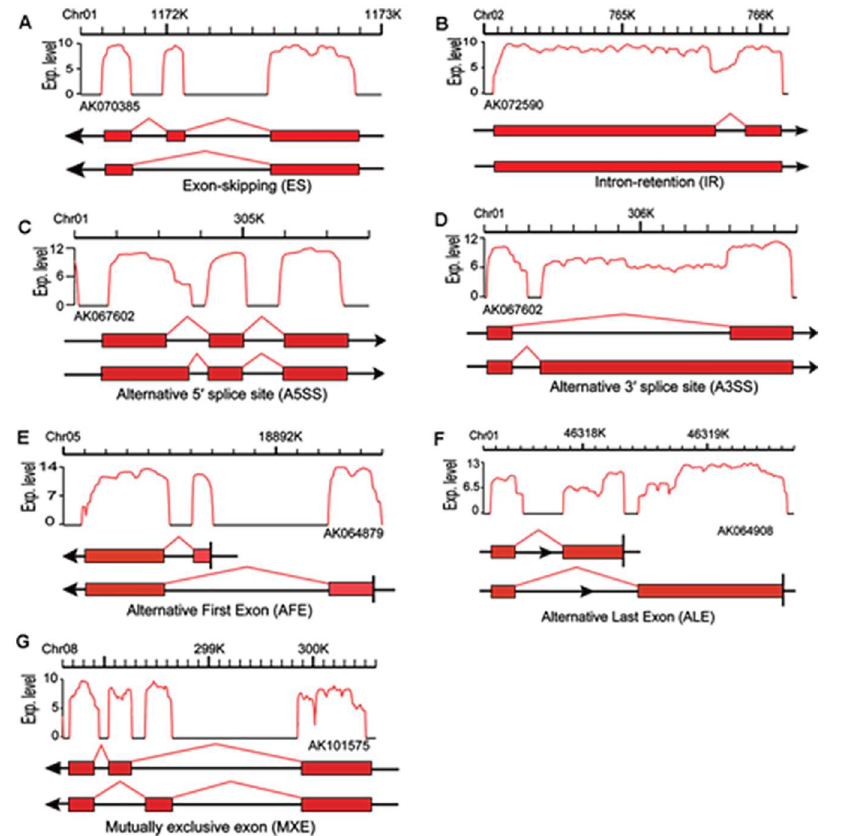
Fig 6. Alternative splicing events “Exp. Level” of Y-axis equals to log2 (Reads